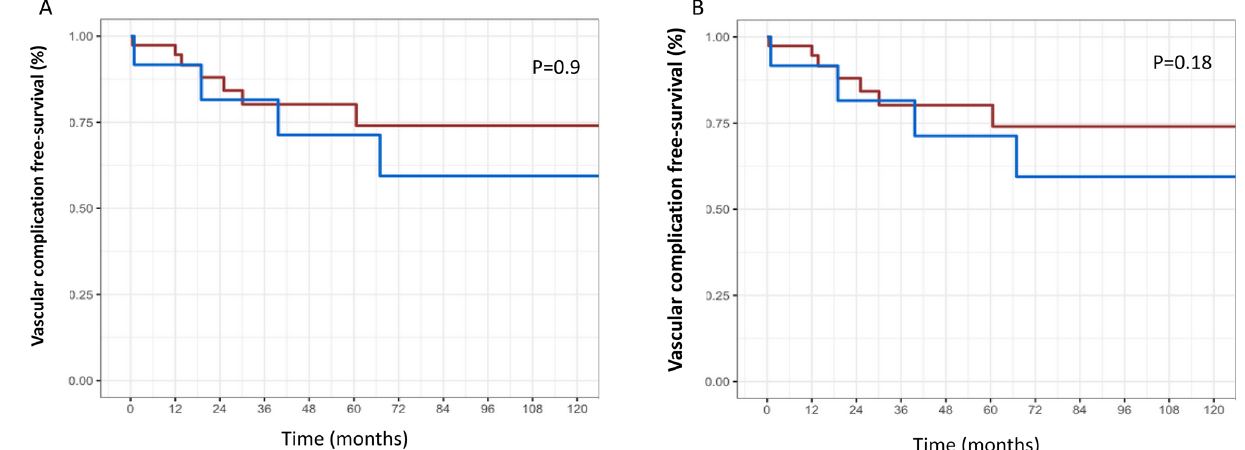
Figure 1. Vascular complication free-survival with (red) and without (blue) statins.